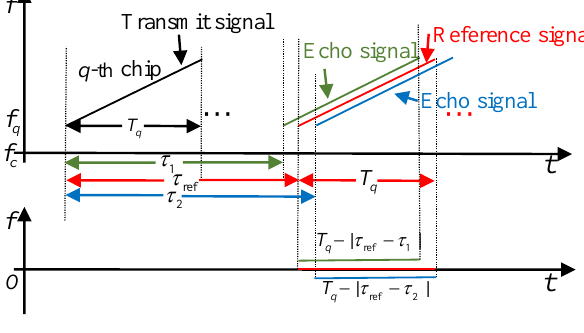
Figure 3. The dechirp process of the q -th